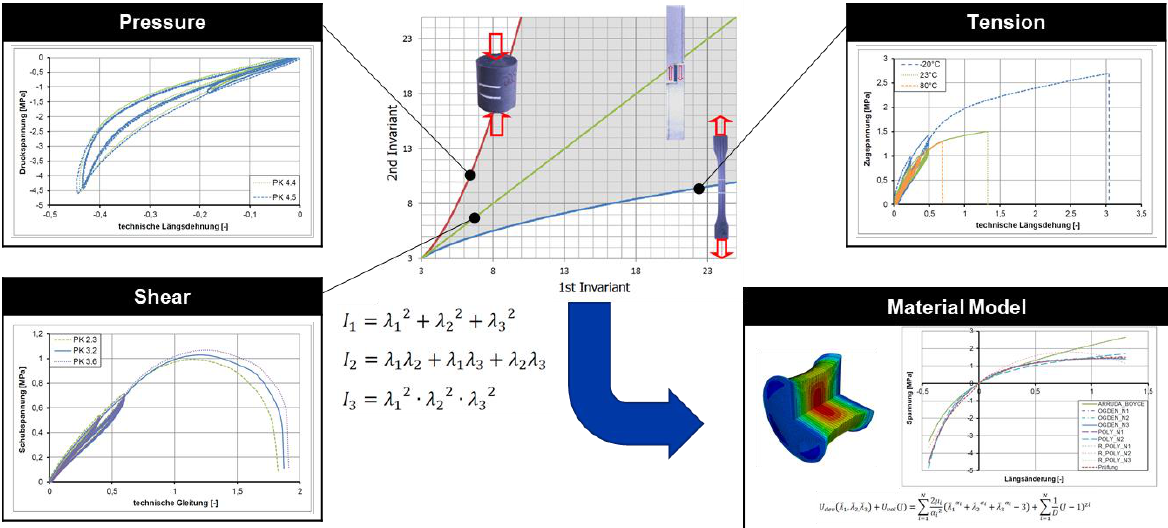
Fig. 2 Exemplary test selection for the parameterization of a material